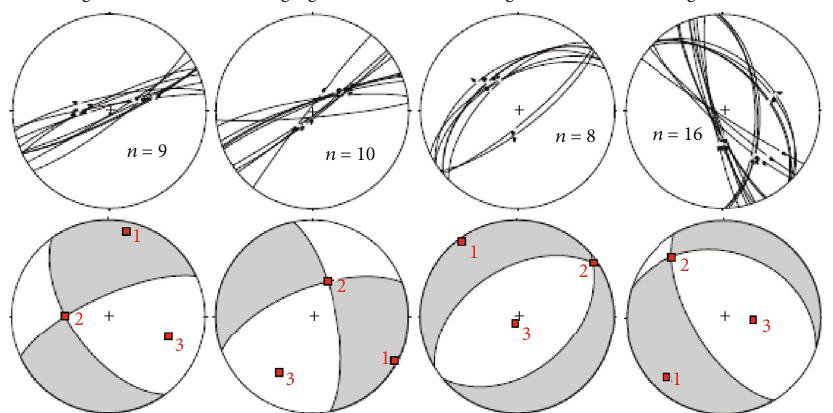
Figure 4: Stereographic diagrams (equiareal diagrams, lower hemisphere) illustrating faults, divided per fault trends, and kinematics and their relative focal mechanism.